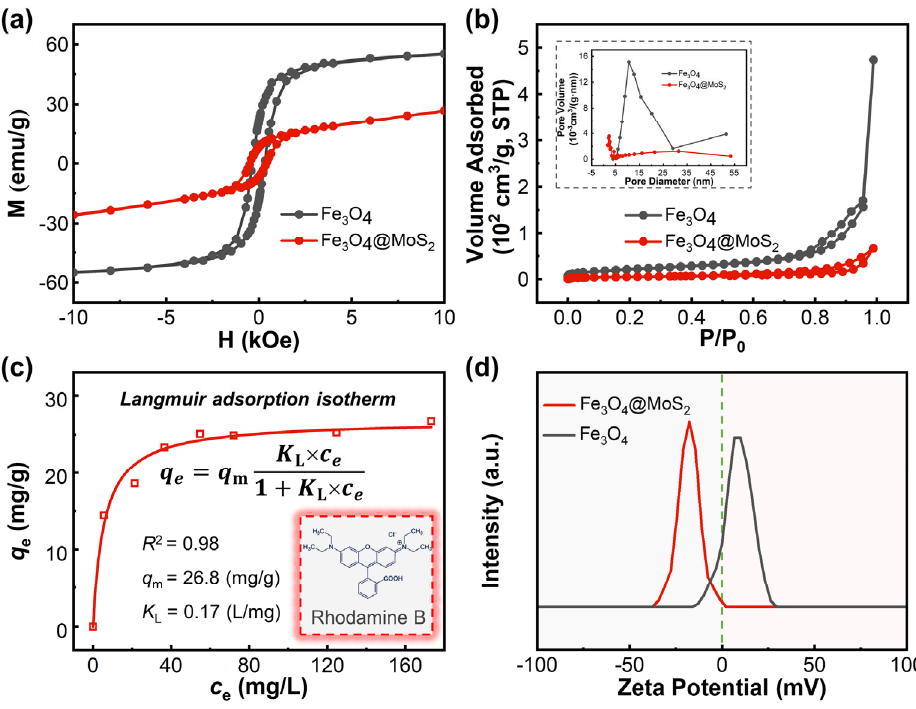
Figure 3. ( a ) M–H hysteresis loops of Fe 3 O 4 and Fe 3 O 4 @MoS 2 measured at 5 K; ( b ) BET adsorption– desorption curves of Fe 3 O 4 and Fe 3 O 4 @MoS 2 , along with their pore size distributions; ( c ) adsorption isotherm of rhodamine B by Fe 3 O 4 @MoS 2 at 298 K, along with the fitted parameters using the Langmuir adsorption isotherm equation, where q e represents the amount of equilibrium adsorption, c e is the equilibrium concentration, q m represents the maximum adsorption capacity, and K L is the Langmuir constant; ( d ) zeta potential distribution graph of Fe 3 O 4 @MoS 2 aqueous dispersion at 298 K.